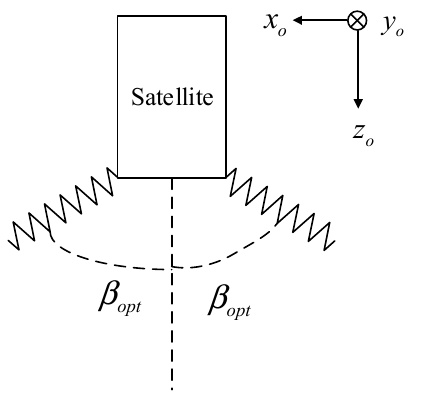
geometry configuration of two helical antennas are presented in Figure 7.